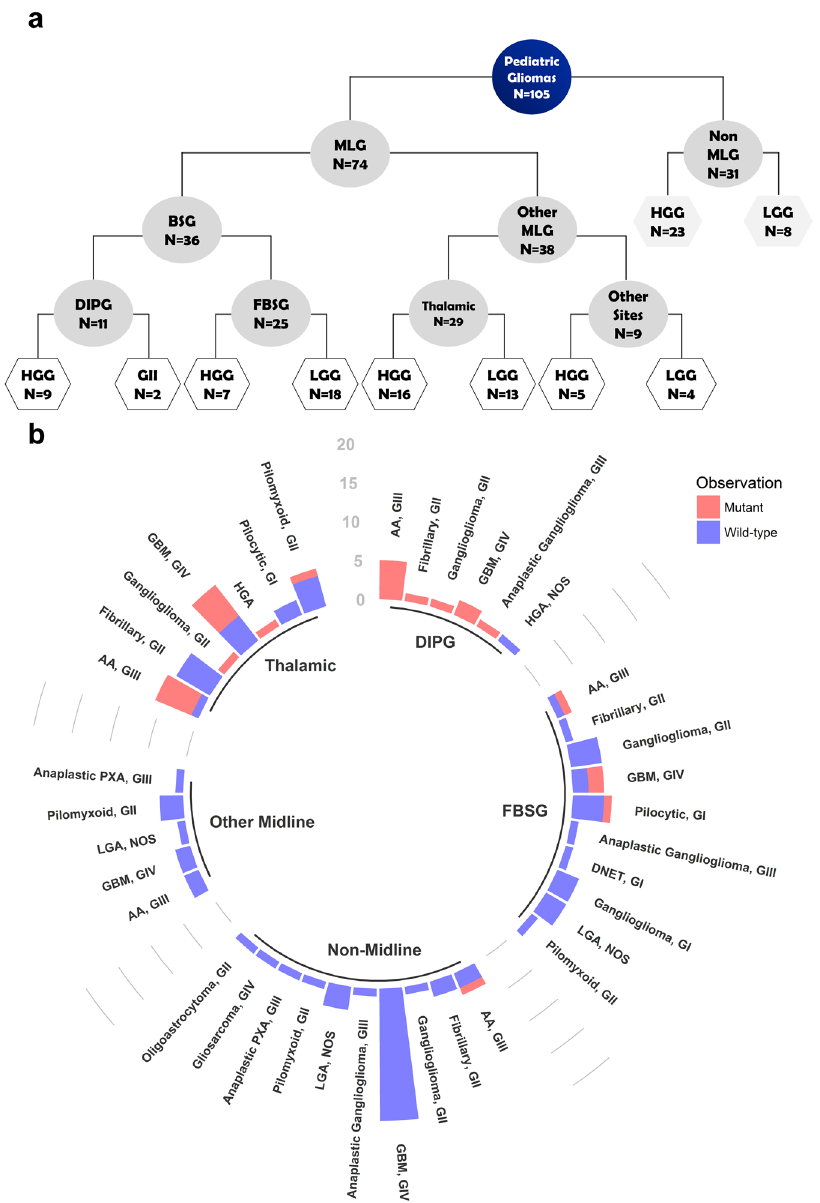
anatomical and histological